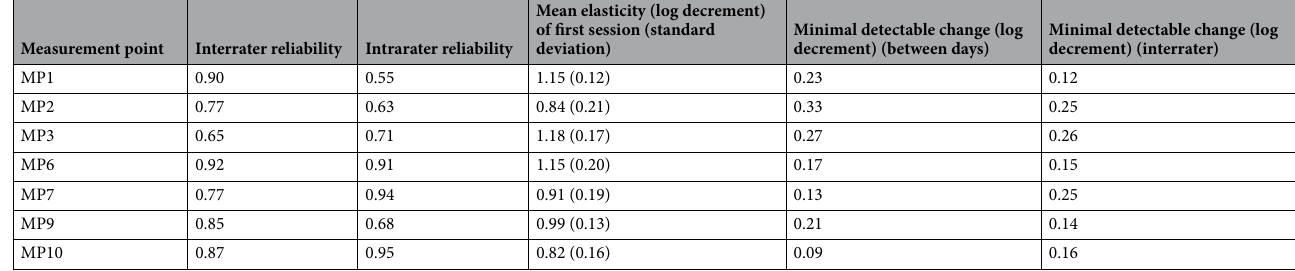
Table 3. Myoton elasticity results for intrarater (between-days) and interrater reliability, mean elasticity of first session and minimal detectable change. MP1 Plantar Fascia, MP2 Achilles tendon, MP3 Soleus, MP6 Splenius capitis, MP7 Anterior Deltoid, MP9 Patellar tendon, MP10 Anterior tibialis.